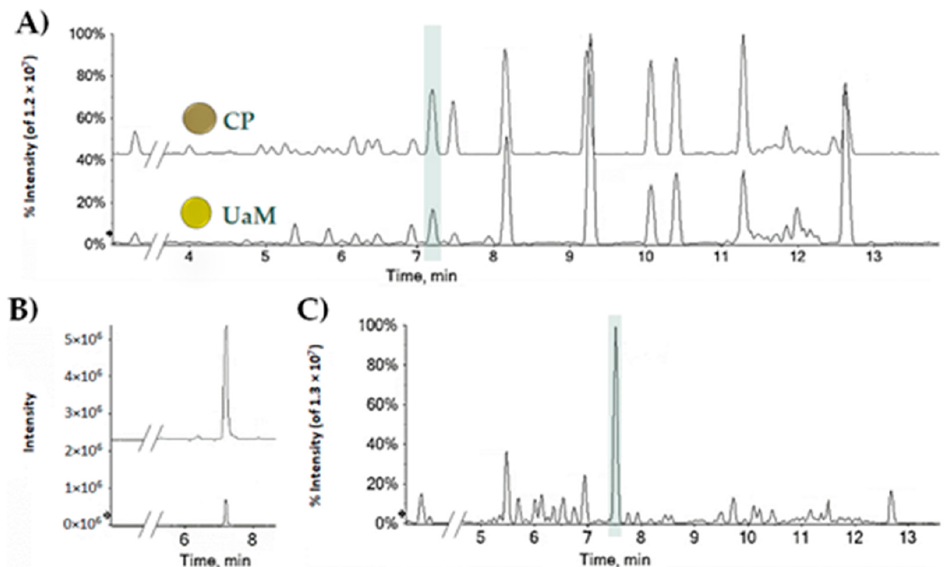
Figure 1. ( A ) TICs (Total Ion Chromatograms) of UaM and CP hemp seed oils; ( B ) XICs (eXtracted Ion Chromatograms) of the ion at m/z 357.2071 ± 0.0025; ( C ) representative TIC of leaf hemp sample collected at seed harvesting